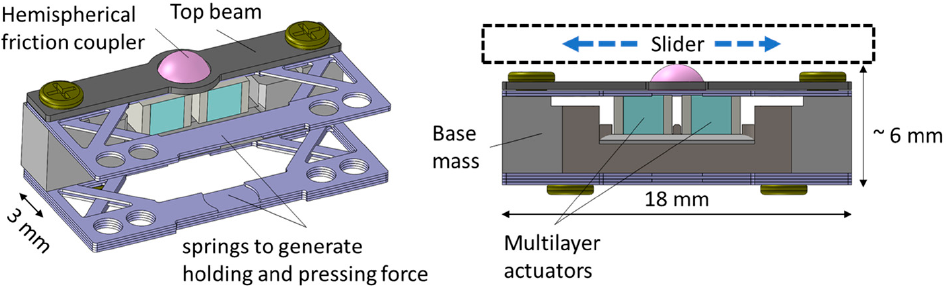
Figure 1. Perspective and side views of the stator showing the possible orientation of a slider. The stator is attached to a motor base from one side of the sheet metal flat springs.